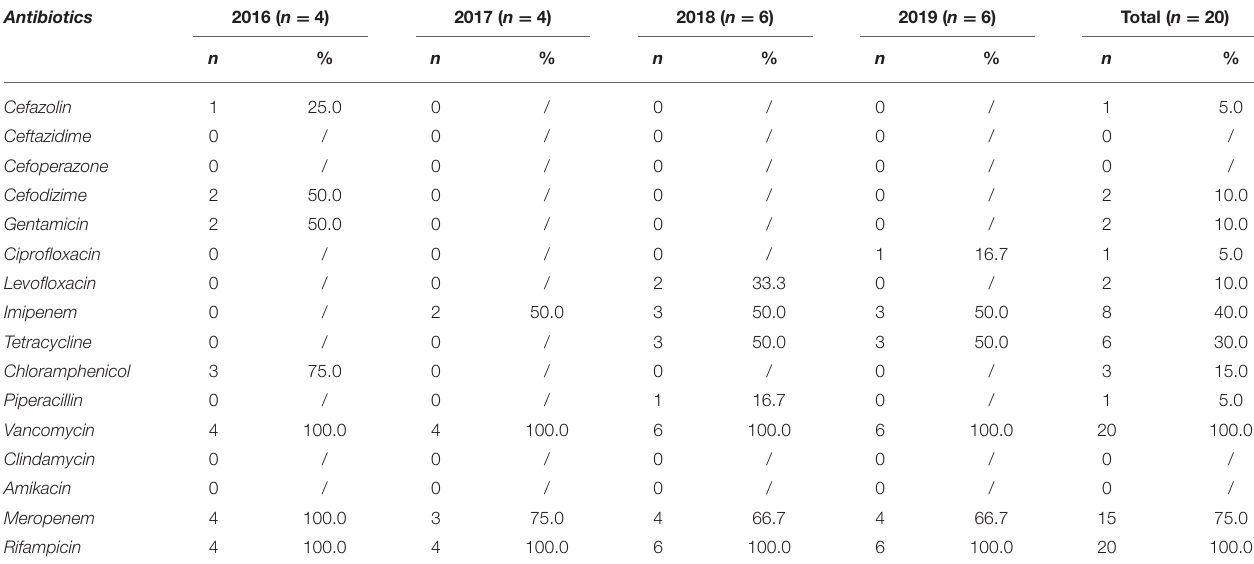
TABLE 5 | Susceptibility of Acinetobacter and Pseudomonas pathogens to antibiotics. Antibiotics